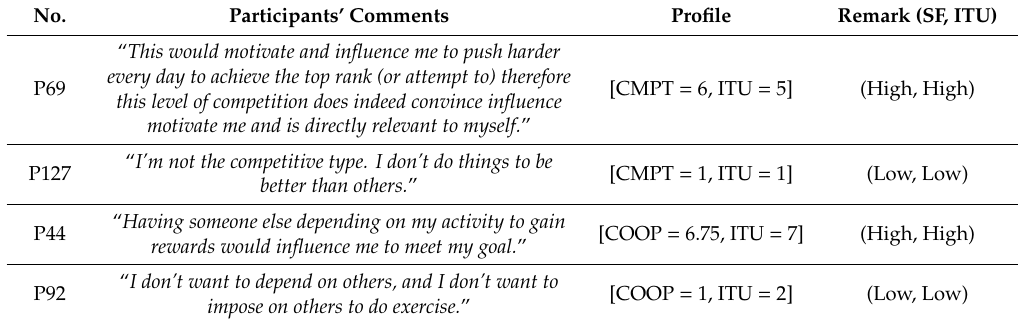
Table 5. Participants’ comments on competition and cooperation features and receptiveness